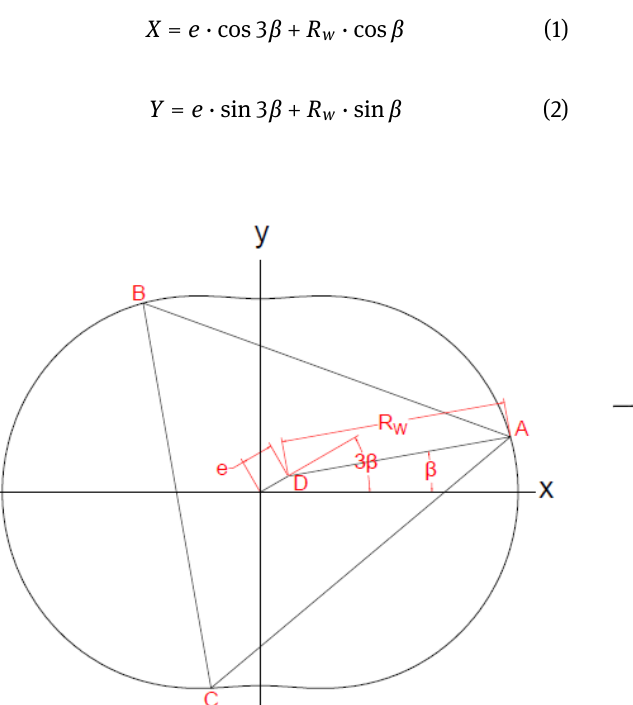
Fig. 1: Wankel Engine Geometry